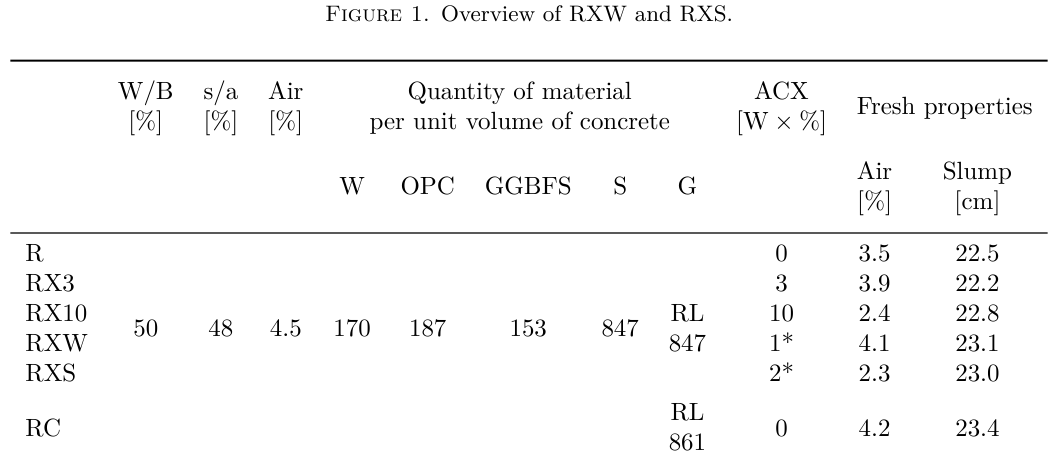
Figure 1. Overview of RXW and RXS.